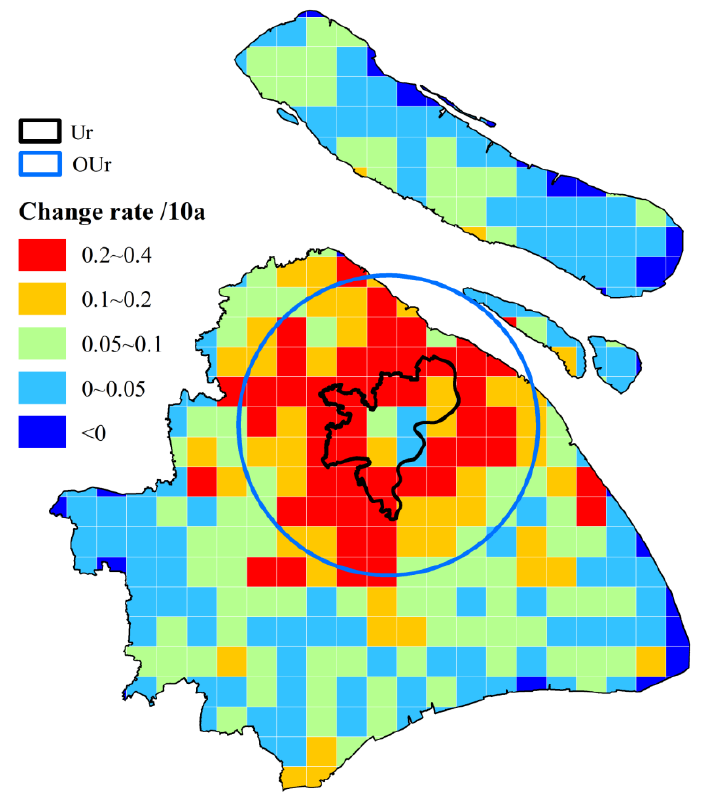
Figure 9. The percentage change rate of the built-up area from 1979 to 2010.